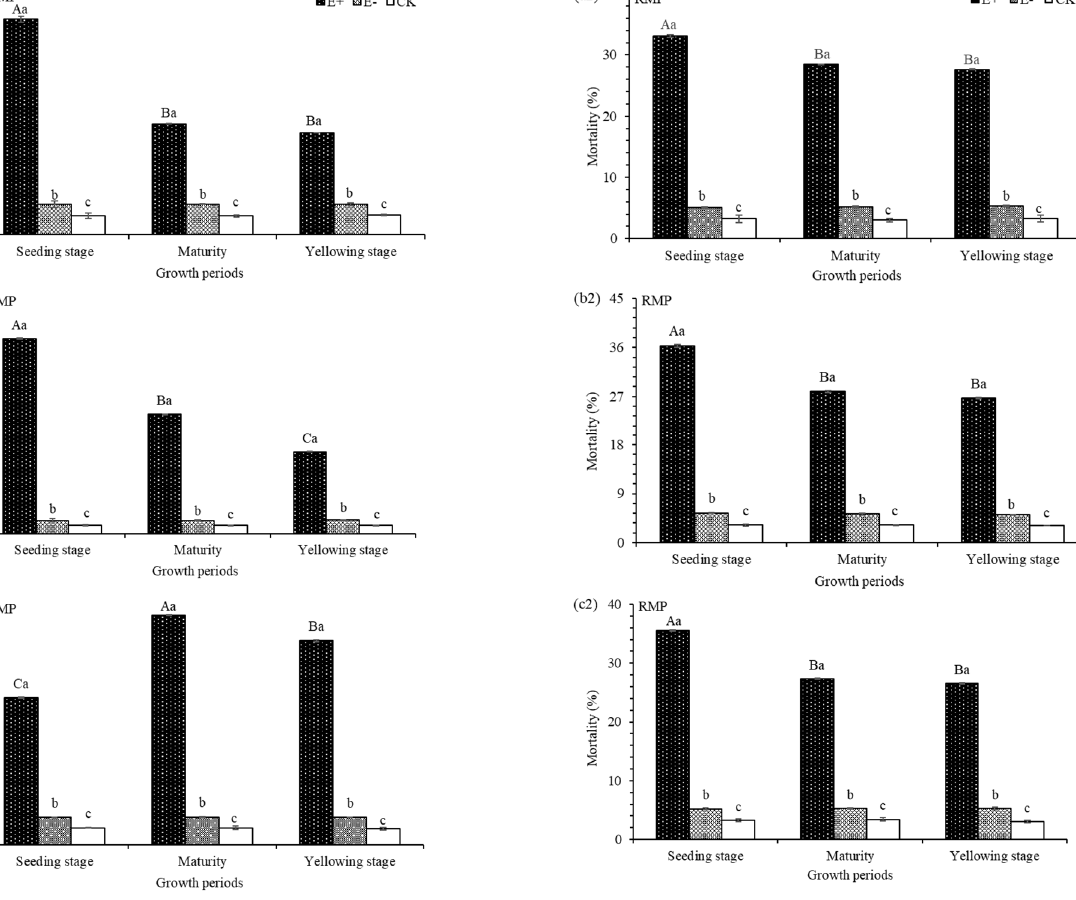
Figure 1. Mortality of green color morphs of pea aphids (GMP) and red color morphs of pea aphids (RMP) after treatment with aqueous extracts from plants after 24 h, 48 h and 72 h exposure ( a1 , a2 , b1 , b2 , c1, and c2 ). E+, endophyte-infected A. inebrians ; E − , endophyte-free A . inebrians ; CK, control. Different capital letters indicate that there are significant differences between different growth periods, and different small letters indicate that there are significant differences between different treatments ( p < 0.05).